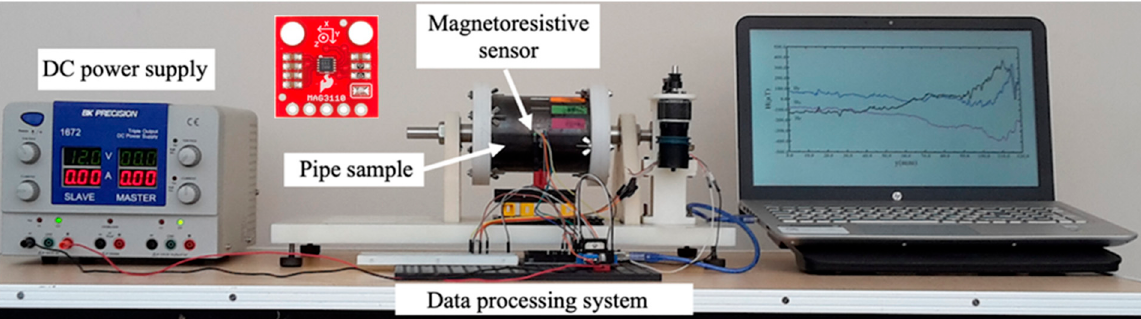
Figure 2. Measurement system of tangential and normal MMM signals around five different V-notch defects on the outer surface of an ASTM-A36 steel pipe.